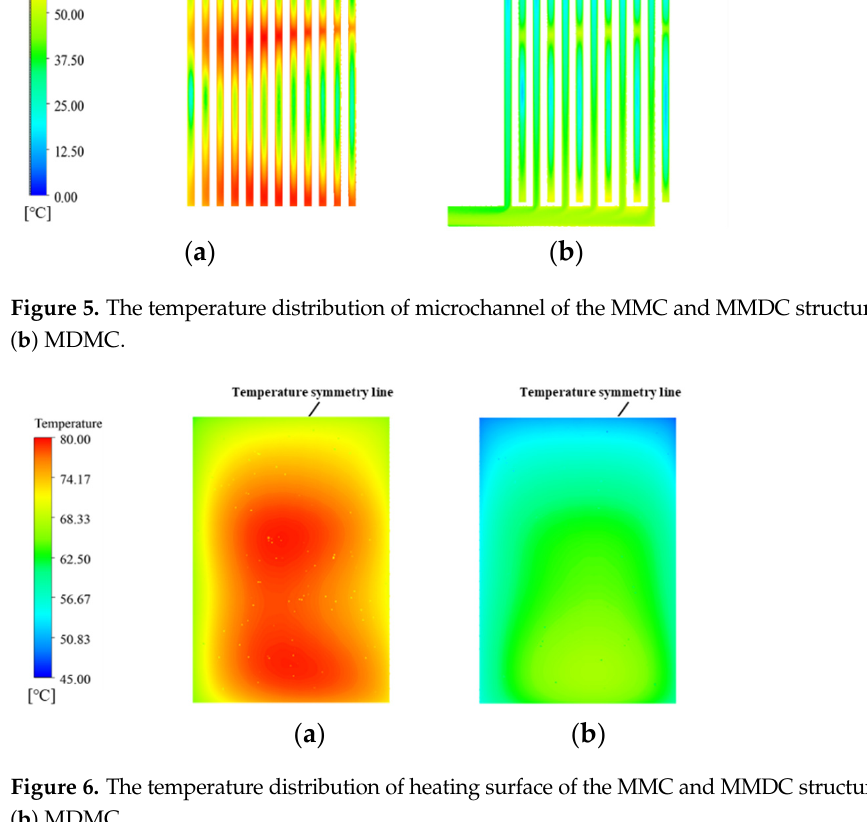
Figure 6. The temperature distribution of heating surface of the MMC and MMDC structures. ( a ) MMC; ( b ) MDMC.